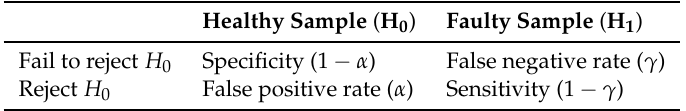
Table 7. Scheme for the presentation of the results in Table 8 (specificity and sensitivity).